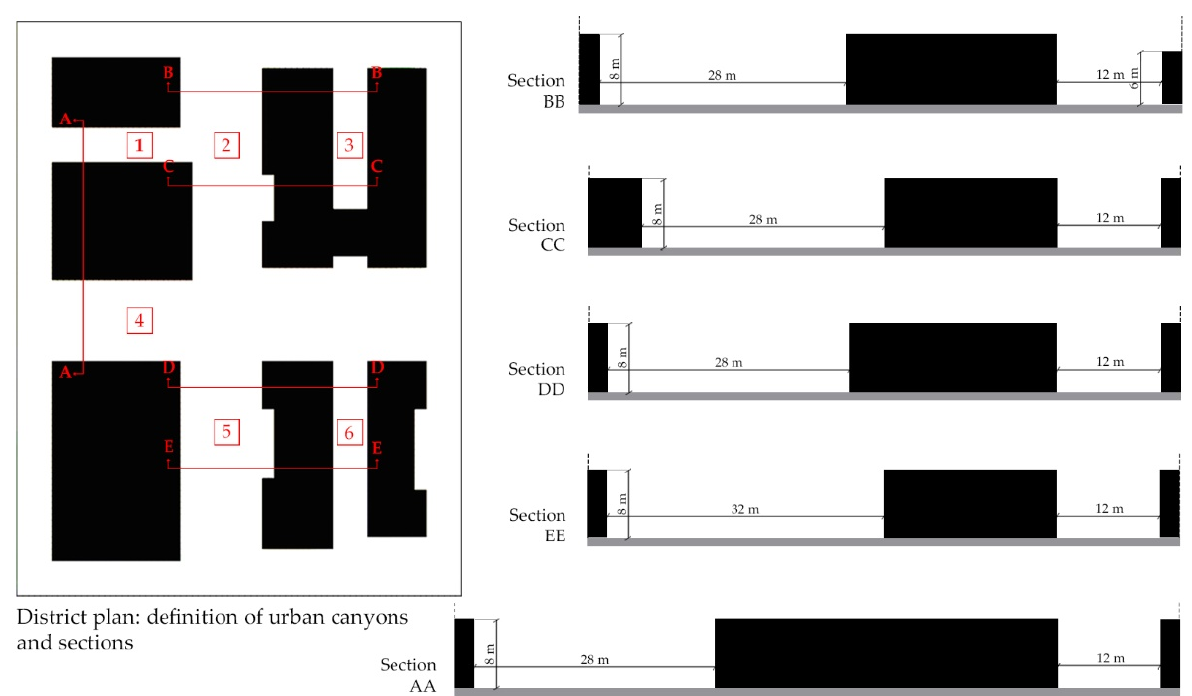
Figure 2. M2 district: plan view and the individuation of the different urban canyons and the corresponding vertical sections.